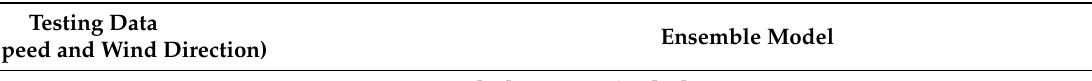
Table 12. Comparison between the proposed SBI and the other ensemble methods using LASSO and ridge